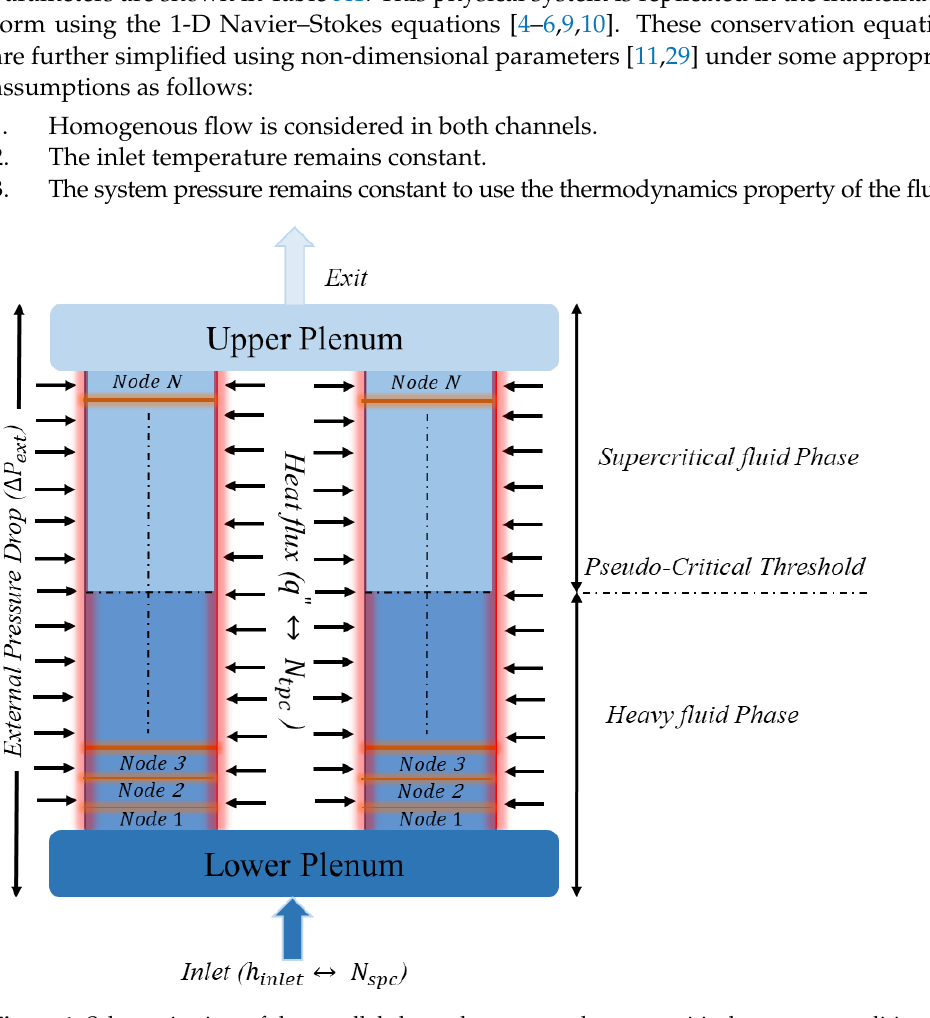
Figure 1. Schematic view of the parallel channel system under supercritical pressure conditions.